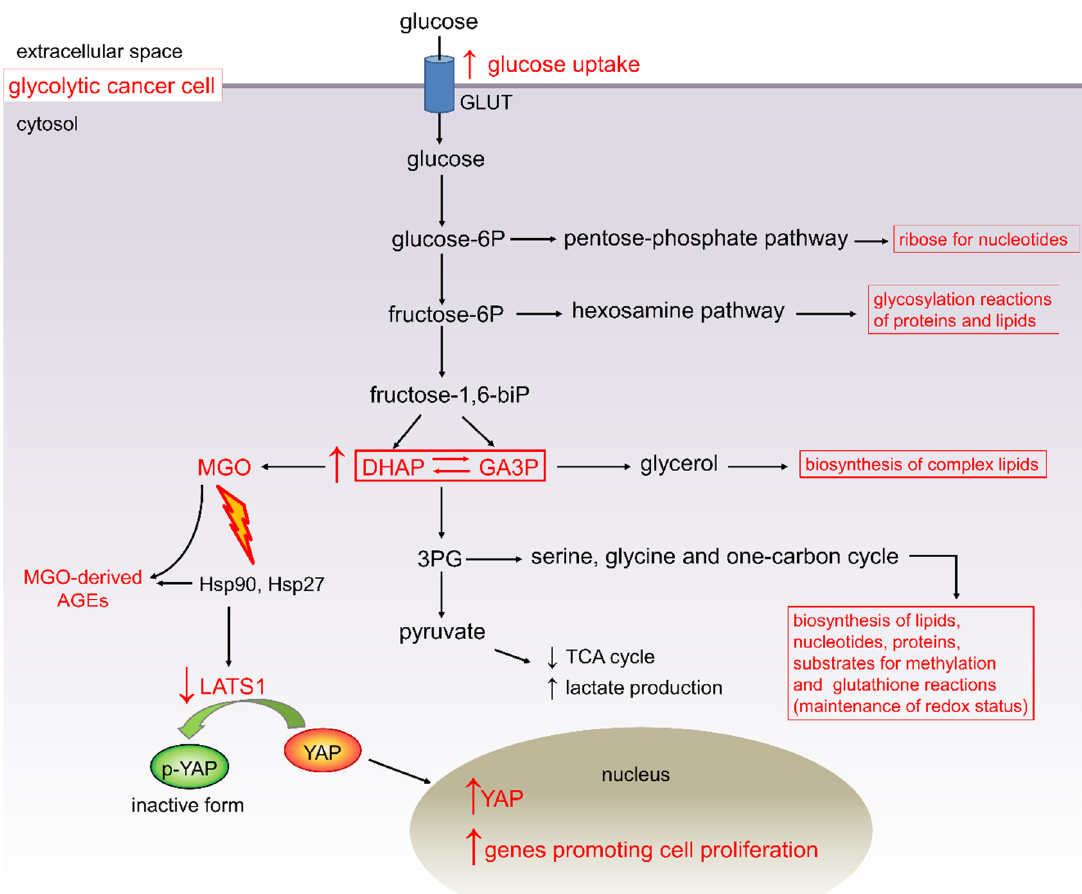
Figure 4. Aerobic glycolysis (Warburg effect) and cell proliferation. In addition to supporting cell growth by feeding several non-mitochondrial anabolic pathways, enhanced glucose flux through the glycolytic pathway directly stimulates cell proliferation through overproduction of the reactive carbonyl species (RCS) methylglyoxal (MGO), which is an inevitable by-product of glycolysis. GLUT = glucose transporter; DHAP = dihydroxyacetone phosphate; GA3P = glyceraldehyde 3-phosphate; 3PG = 3-phosphoglycerate; AGEs = advanced glycation end-products; TCA = tricarboxylic acid; LATS1 = large tumor suppressor kinase 1; YAP = yes-associated protein.